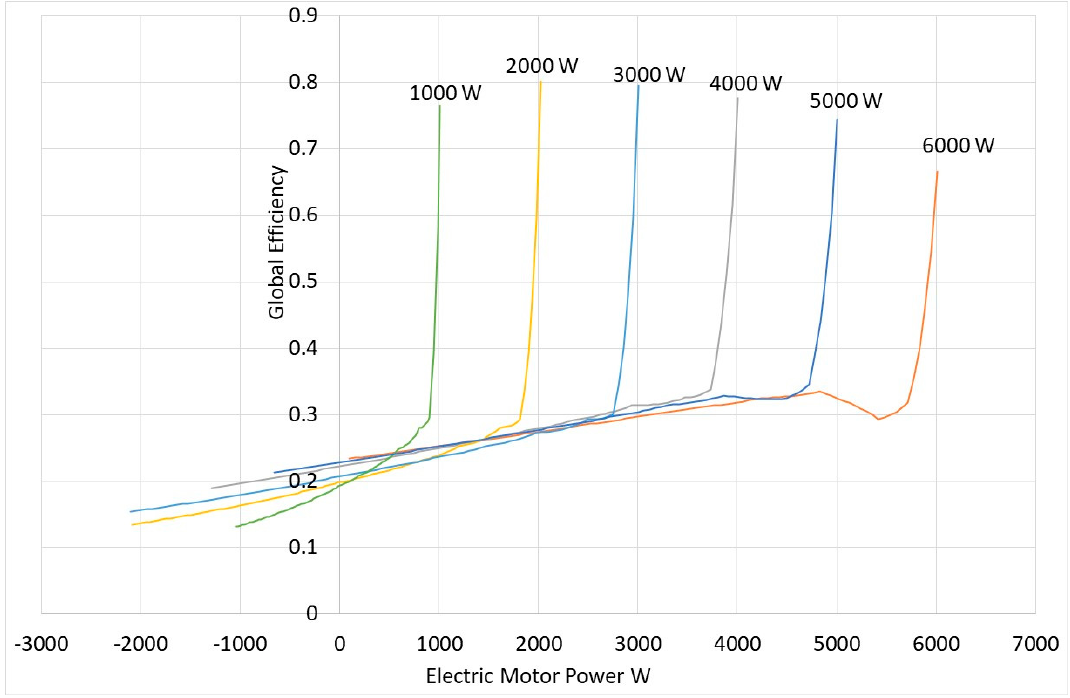
Figure 8. Efficiency of the powertrain for different wheel power values (from 1000 W to 6000 W) and Figure 8. E ffi ciency of the powertrain for di ff erent wheel power values (from 1000 W to 6000 W) and different values of electric motor power. di ff erent values of electric motor